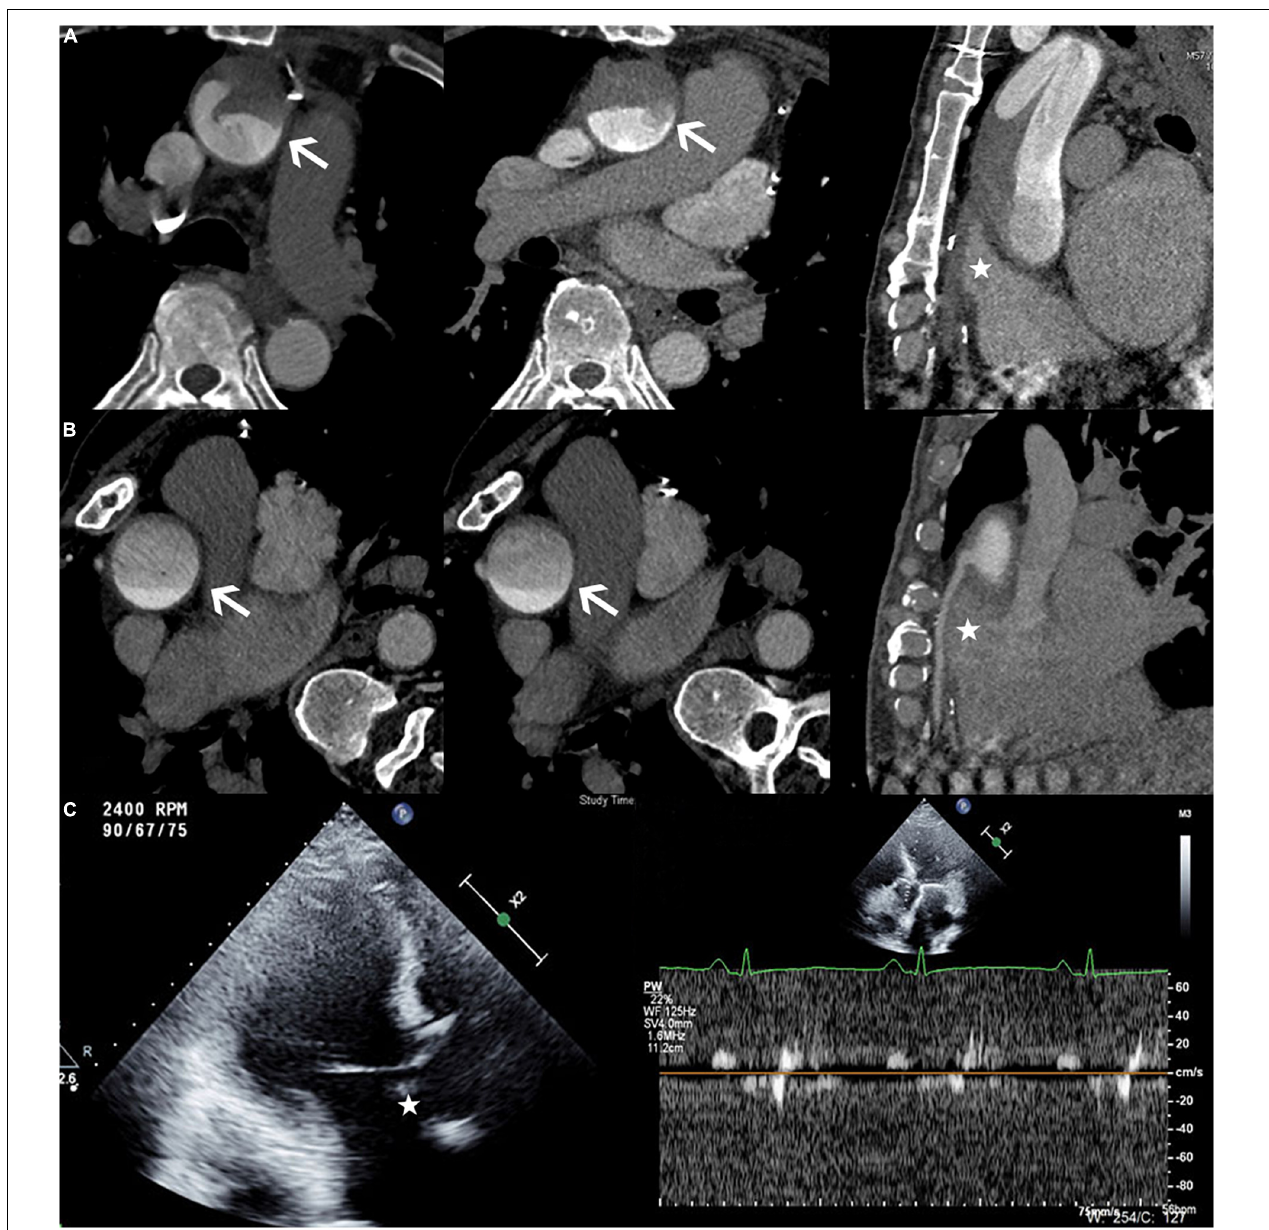
FIGURE 2 | (A) Patient in the supine position. The axial view demonstrating an arc-shaped low-attenuation filling defect (white arrow) was seen in the root of the aorta, while the DAO was filling well. The multiplanar reformatted image from the CTA showed no contrast agent filling in the bypass of the right coronary artery (white star). (B) Patient in the right lateral decubitus position. The arc-shaped low-attenuation filling defect disappeared (white arrow), and the bypass of the right coronary artery filled well (white star). (C) The echocardiography (Philips EPIQ 7C; 45 ◦ reclining position; Three-chamber view) demonstrated the extremely low velocity of the aortic valve and no thrombus formation in the aortic root (white